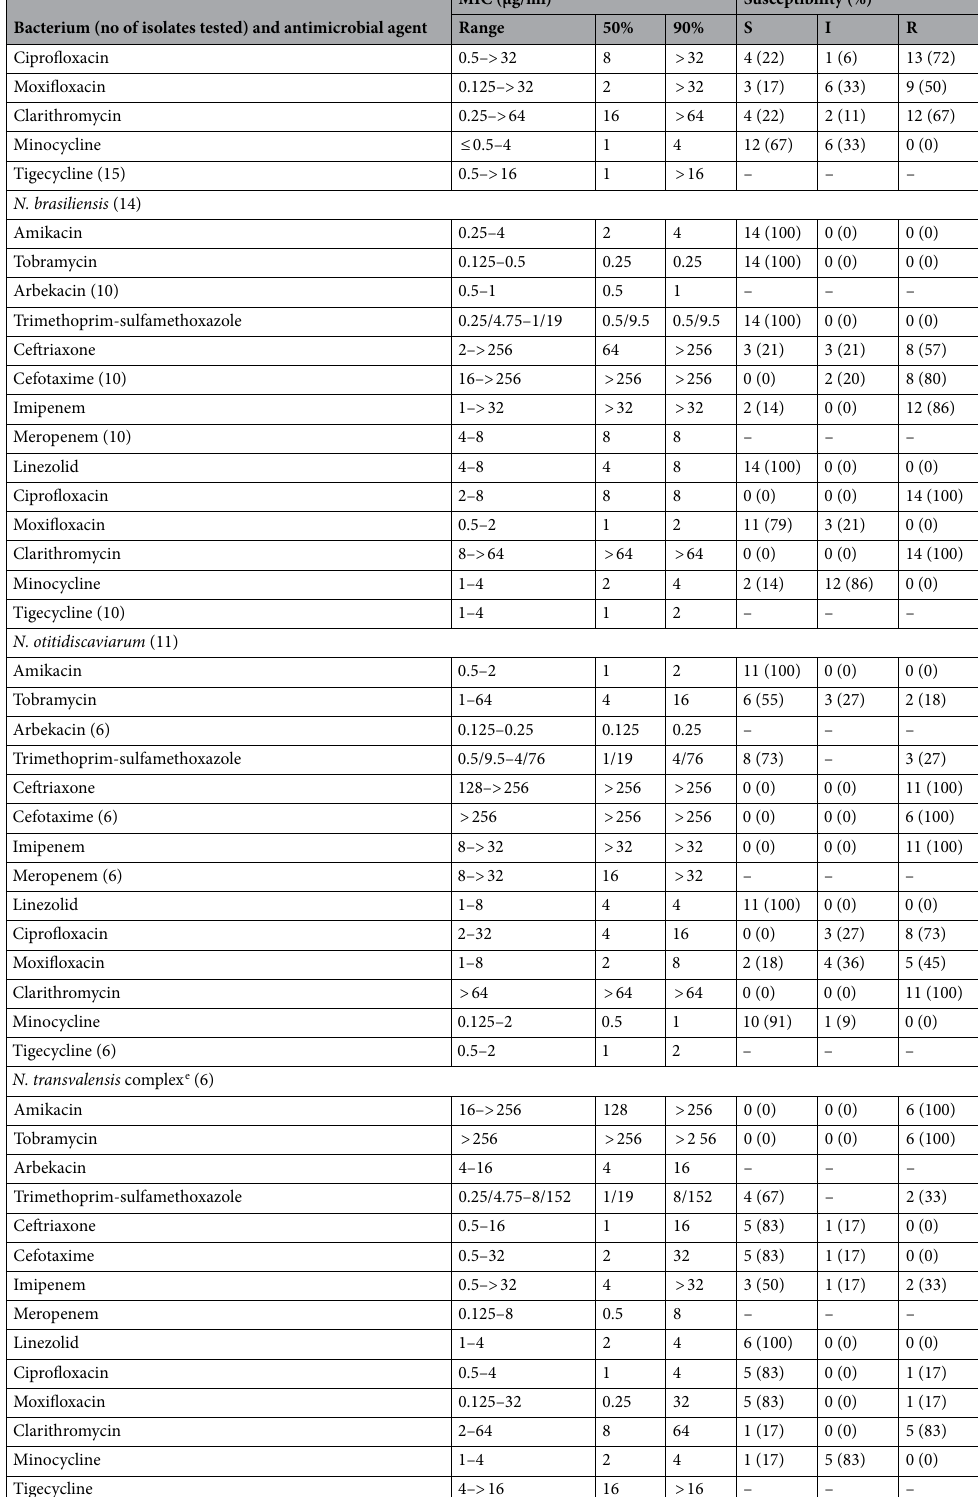
Table 2. Activities of antimicrobial agents against the 7 most frequently isolated Nocardia species/complexes. a S, susceptible; I, intermediate; R, resistant. b N. farcinica and Nocardia kroppenstedtii were included in the N. farcinica complex. c N. nova , N. elegans , and N. aobensis were included in the N. nova complex. d N. abscessus , N. asiatica , N. beijingensis , and N. arthritidis were included in the N. abscessus complex. e N. wallacei and N. transvalensis were included in the N. transvalensis